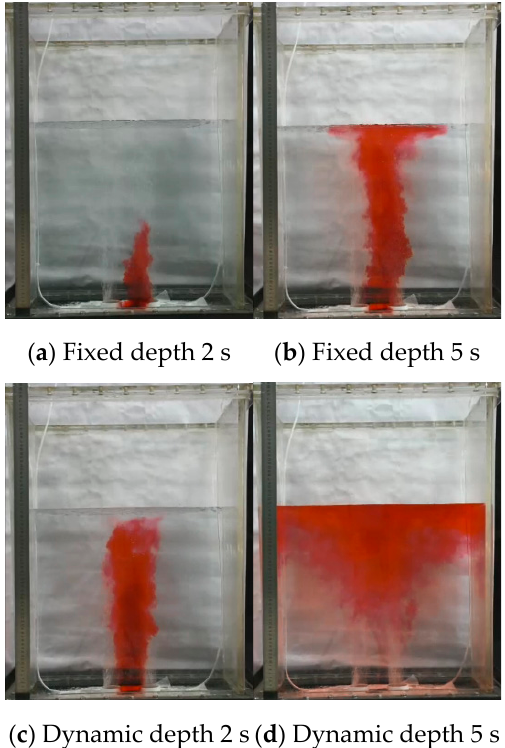
Figure 7. Tracer patterns in different measurement methods.